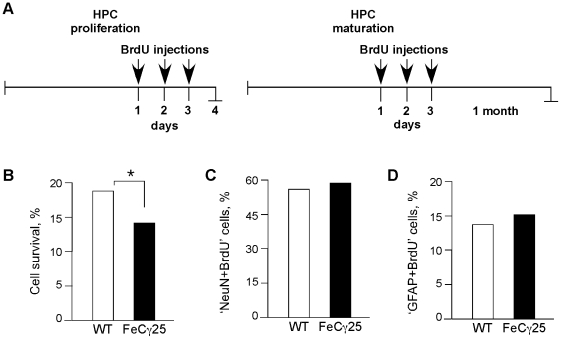
AICD downregulates cell survival but does not affect differentiation of newly generated hippocampal cells.
A, Experimental design to measure HPC proliferation or HPC maturation. After the last BrdU injection, mice were sacrificed after 1 day (proliferation) or 1 month (maturation) and HPC survival was quantified as the ratio of the number of BrdU+ cells present at 4 weeks post-BrdU to the number of BrdU+ cells present one day after the last BrdU injection. (B) FeCγ25 mice (13.7, SEM 0.02) showed a significant reduction in the cell survival potential compared to wild-type mice (18.3, SEM 0.02) (* p = 0.012, χ2 test). C–D, Quantitative analysis of the number of BrdU+ cells that mature into neurons (C) and astrocytes (D) 4 weeks after birth. Analysis reveals that AICD does not influence the proportion of surviving cells that mature into neurons (NeuN+, wild-type = 54.8, SEM 0.04; FeCγ25 = 56.6, SEM 0.1) or astrocytes (GFAP+, wild-type = 14.0, SEM 0.02; FeCγ25 = 15.1, SEM 0.03). n = 3 for all.